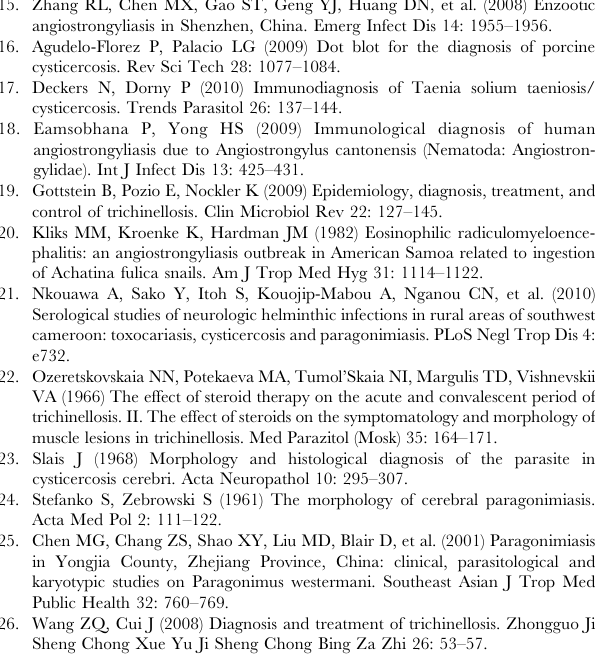
Table S1 The diagnoses of 365 patients by parasitolog- ical or serological methods. Found at: